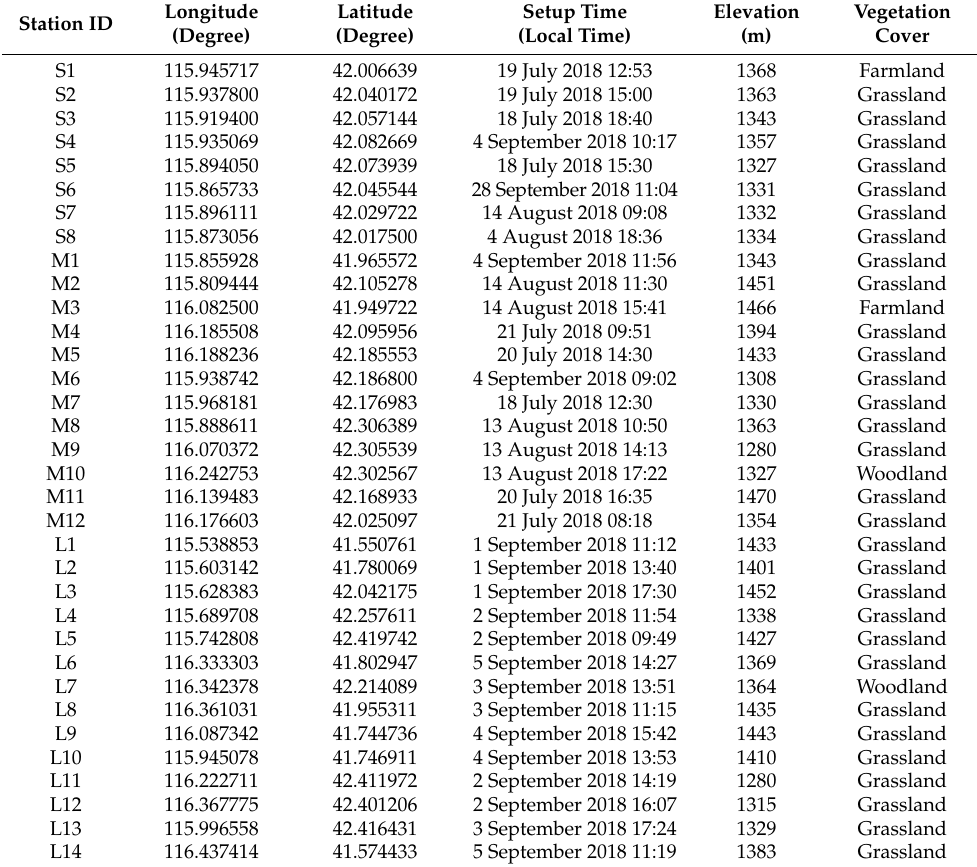
Table 1. Specifications of in situ soil moisture stations at the